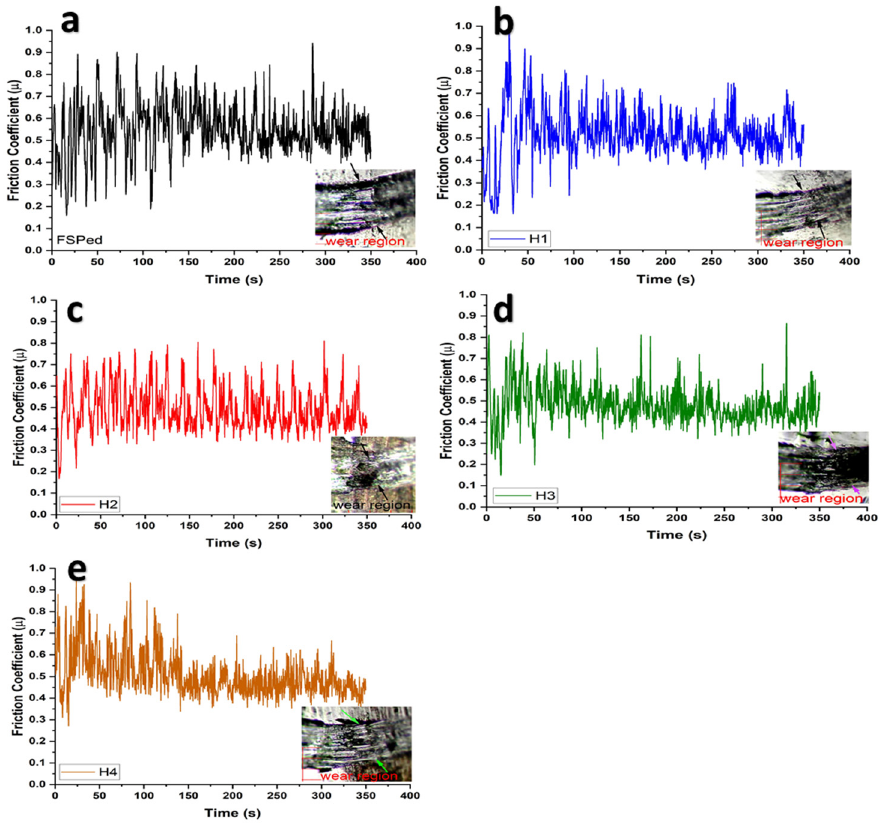
Figure 10. Friction coefficient profile, ( a ) the friction stir processed wear zone, ( b ) Al 2024-H1, ( c ) Al 2024-H2, ( d ) Al 2024-H3, and ( e ) Al 2024-H4.